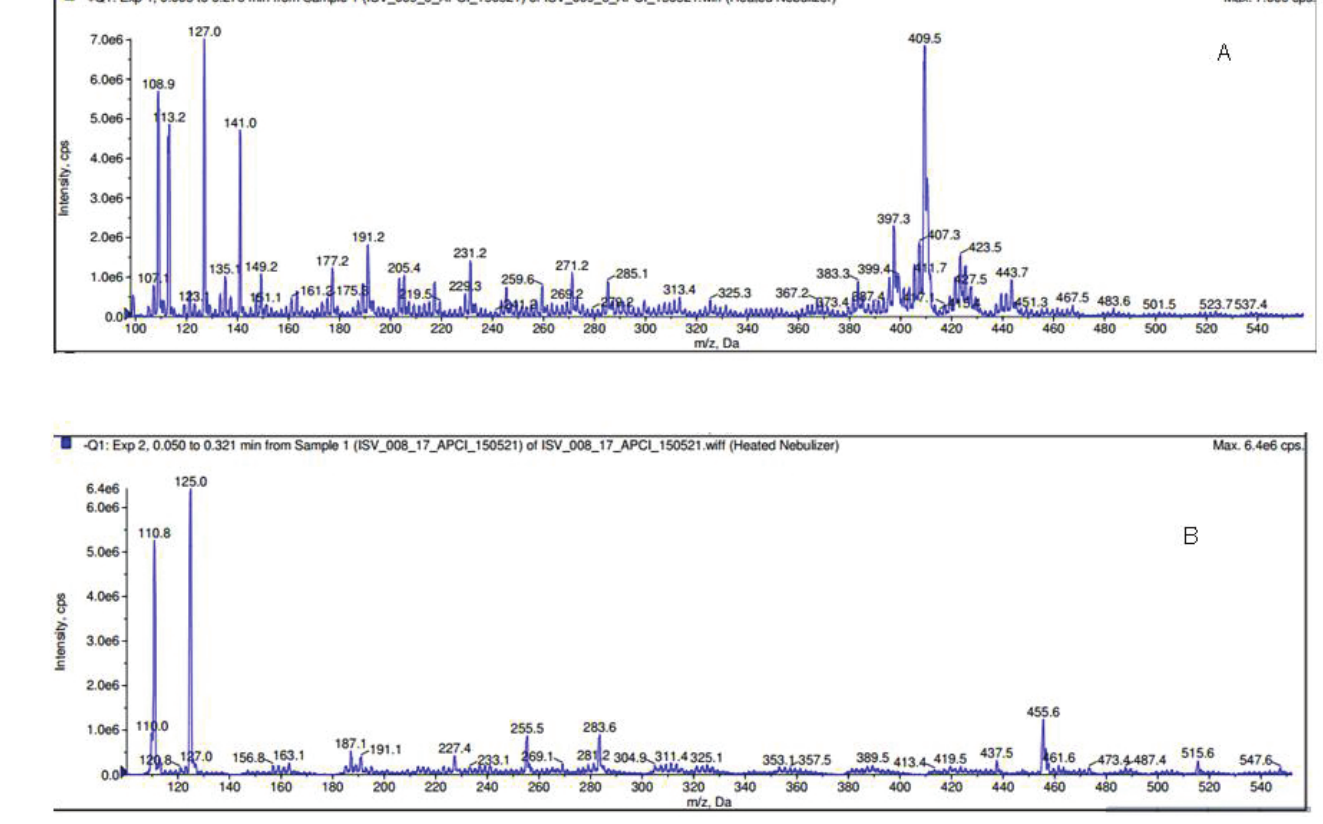
FIGURE 3 - APCI chromatogram of β-amyrin (A) and oleanolic acid